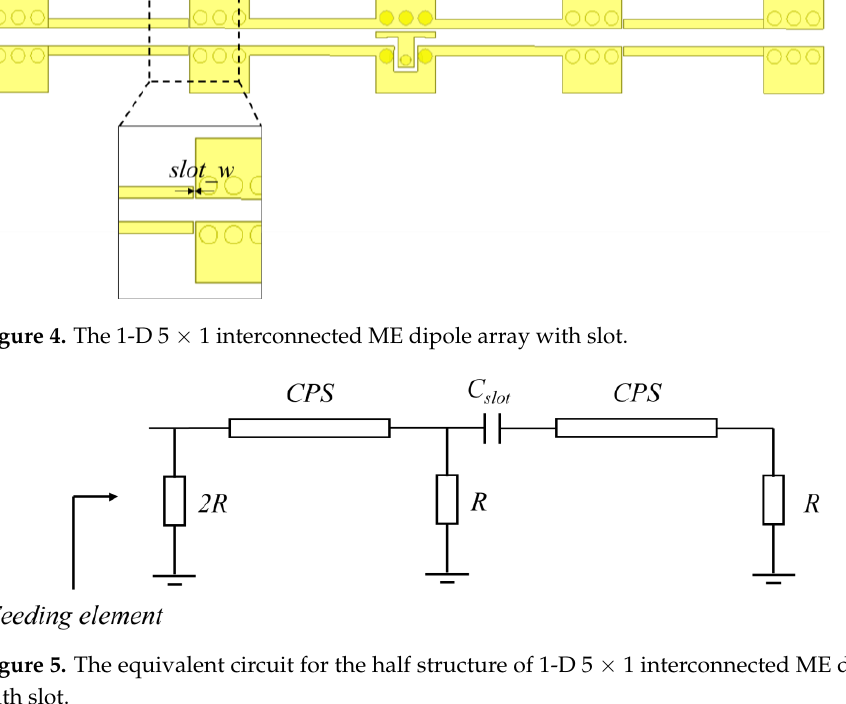
Figure 4. The 1-D 5 × 1 interconnected ME dipole array with slot.